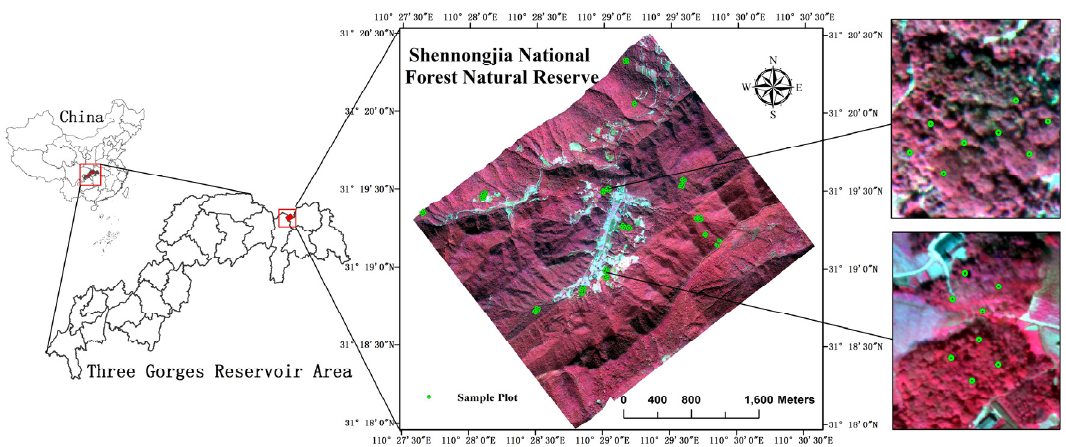
Figure 1. Location of study area with field-measured sample plots.